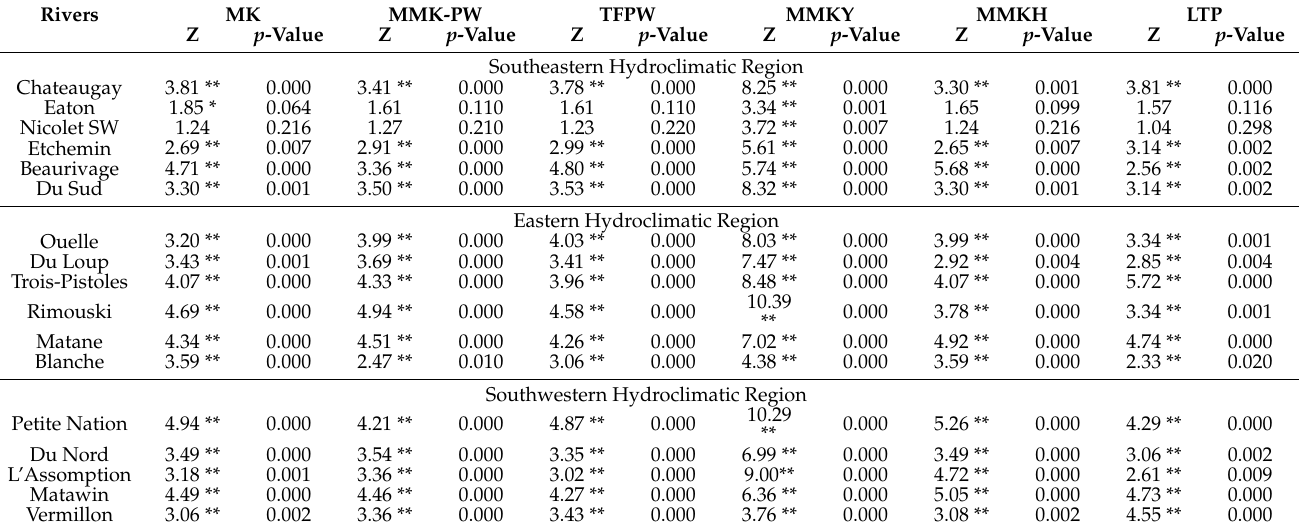
Table 3. Results of the various Mann–Kendall tests applied to daily maximum flow series in winter from